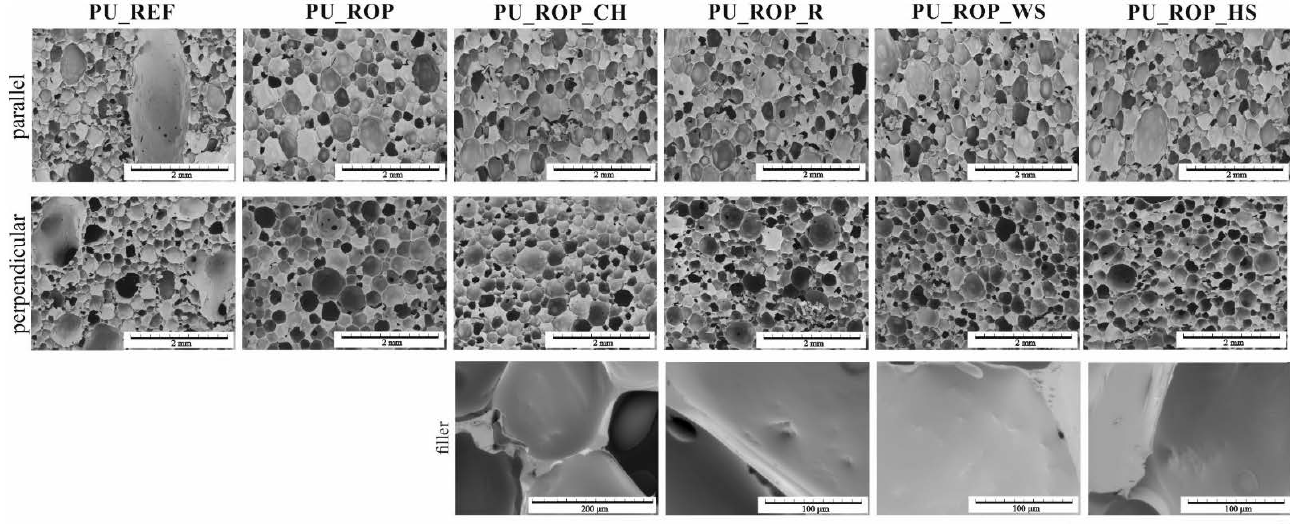
Figure 7. SEM images of the